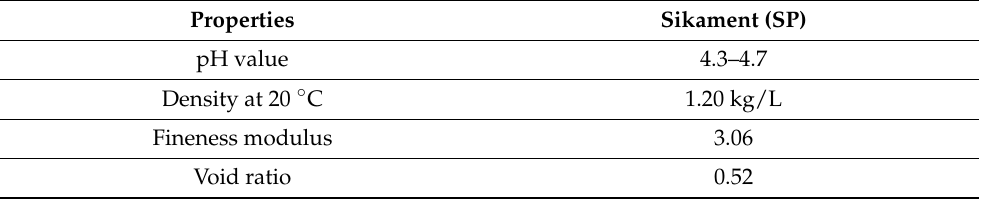
Table 4. Properties of superplasticizer Sikament 163 M(SP) from the manufacturer data sheet.